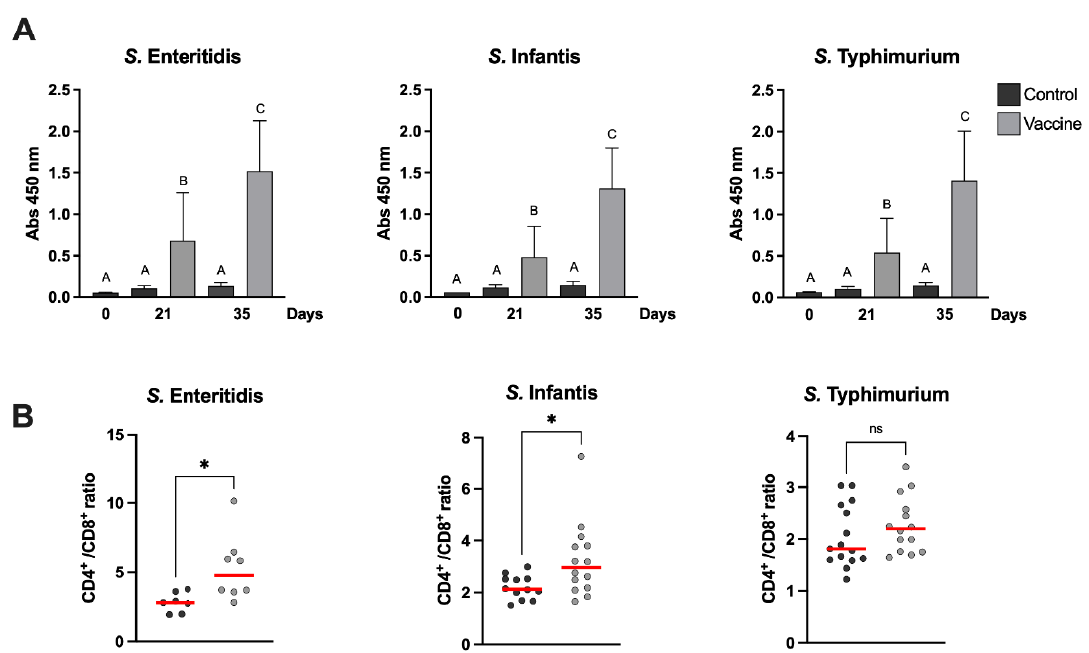
Figure 2. Effect of vaccines on the level of serum-specific Salmonell a IgY and flow cytometry analyses of CD8+/CD4+ cell ratio. ( A ) IgY quantification in immunized or control chickens on days 1 and 21 after first vaccination. Data show mean ± SD of 14 chickens per group. The Kruskal – Wallis test followed by Dunn’s post -test were performed; different letters represent significant differences ( p ≤ 0.05). ( B ) Peripheral T lymphocytes were immunostained, and the frequency of CD3+CD4+ and CD3+CD8+ lymphocytes in blood was determined. Figure shows the CD4+/CD8+ ratio in the vaccinated and control groups, 7 days after challenge. Red lines correspond to the median of each group and asterisks show significant differences ( p ≥ 0.05) obtain ed by unpaired t -test.